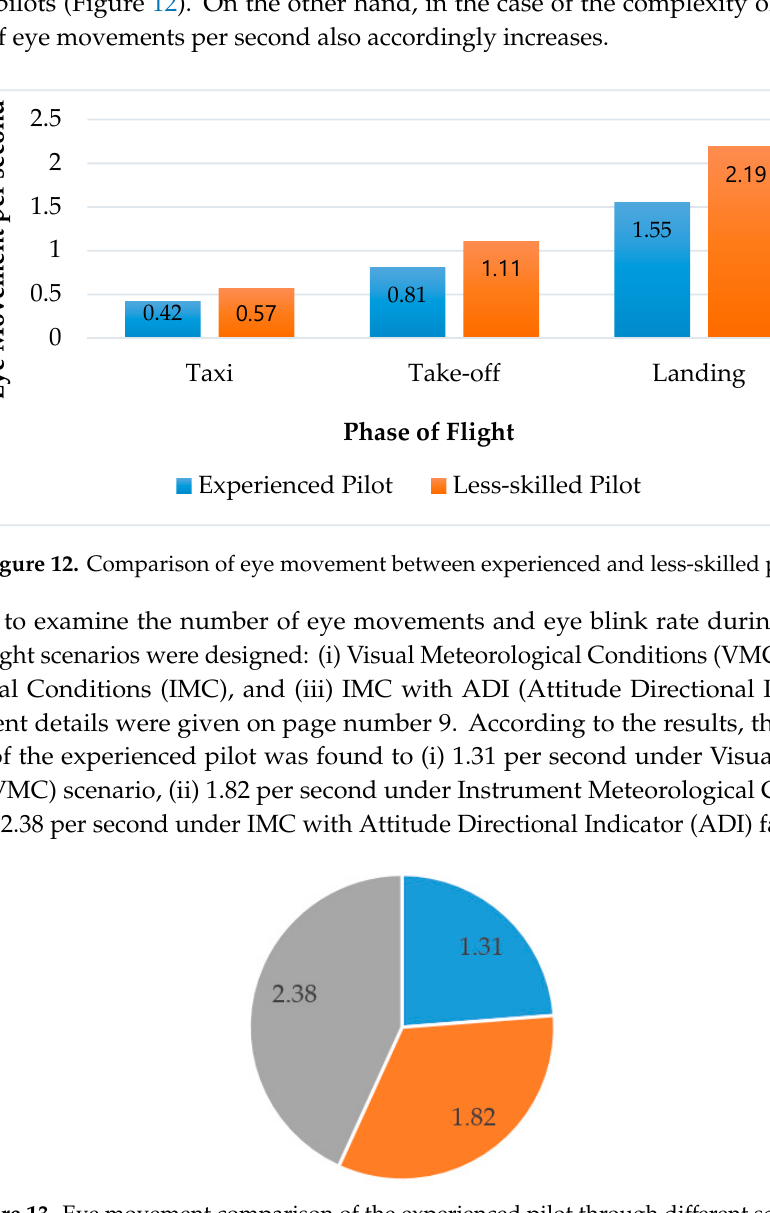
Figure 13. Eye movement comparison of the experienced pilot through different scenarios.